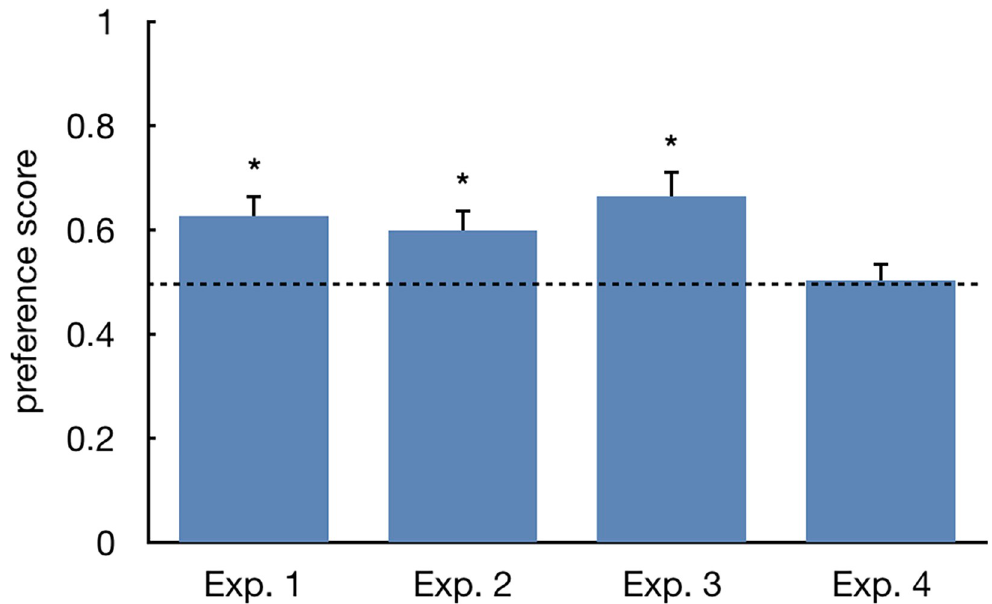
Fig 3. Preference score. Average preference score (Y axis) for each experiment. Means and S.E.M. are shown. Asterisks ( � ) represent significant departures from the chance level of 0.5, marked by the dotted line (p <